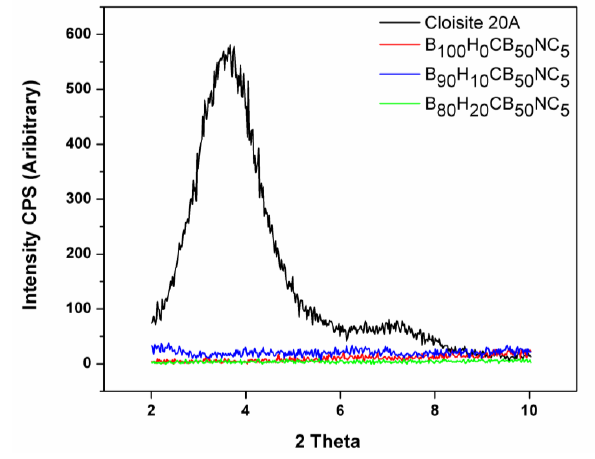
Figure 1: XRD reveals complete exfoliation of the nanoclay in the rubber nanocomposites.